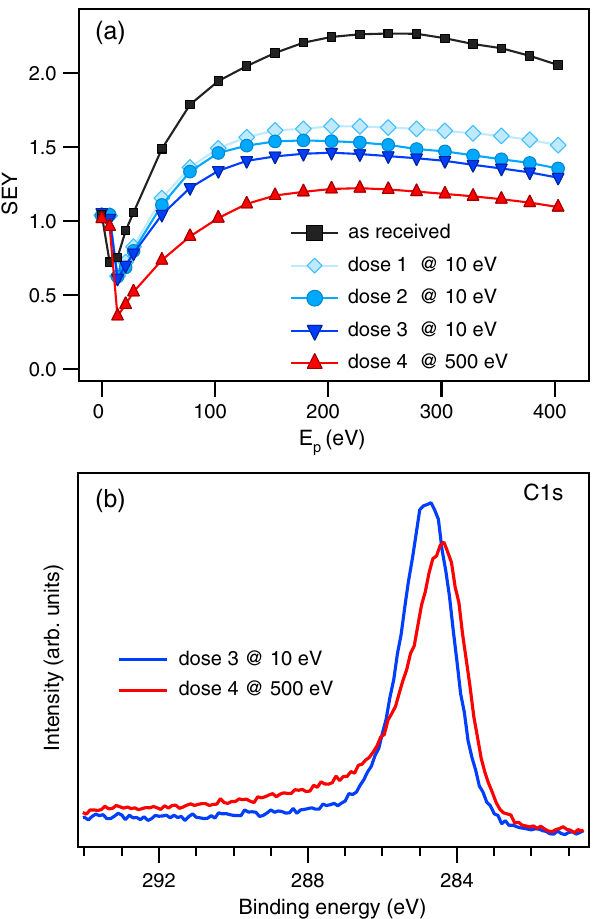
FIG. 4. (a) SEY curve measured on the colaminated Cu sample for LHC beam screen as-received and in the middle of the area ( 3 (cid:3) 3 mm 2 ) scrubbed with 10 eV electrons (dose 1: Q ¼ 3 : 2 (cid:3) 10 (cid:1) 3 C = mm 2 ; dose 2: Q ¼ 4 : 8 (cid:3) 10 (cid:1) 3 C = mm 2 ; dose 3: Q ¼ 1 : 1 (cid:3) 10 (cid:1) 2 C = mm 2 ), and afterwards scrubbed with 500 eVelec- trons (dose 4: Q ¼ 1 : 2 (cid:3) 10 (cid:1) 3 C = mm 2 ); (b) C1s core level spectra taken on the sample surface scrubbed at 10 eV (dose 3) and subsequently scrubbed at 500 eV (dose